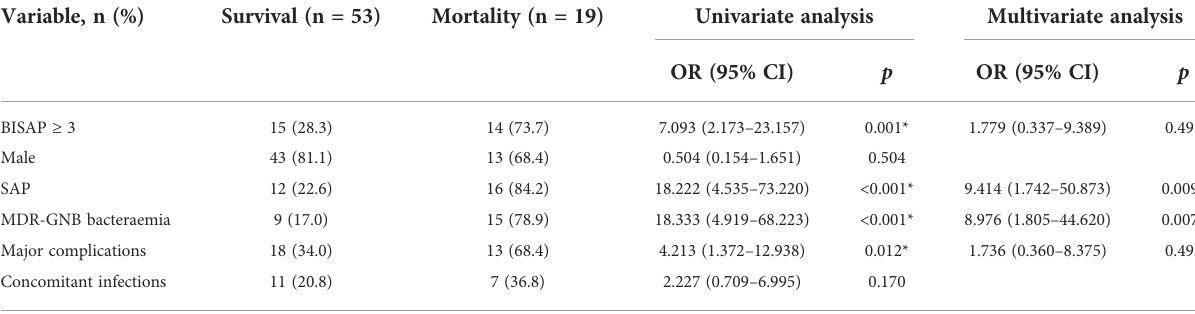
TABLE 3 Univariate and multivariate analyses of predictors associated with mortality in 72 IPN patients. Variable, n (%) Survival (n = 53)